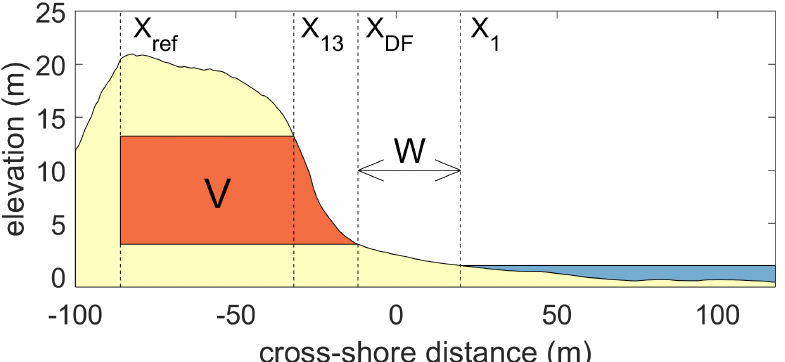
Figure 5. Definitions used for the analysis. Positions of the landward boundary ( X ref ), 10 m elevation contour ( X 13 ), the dune foot ( X DF ) and the 1 m elevation contour ( X 1 ). These positions are used to calculate dune volume ( V ) and beach width (W). Cross-section shown is located at alongshore coordinate 1100 m in later